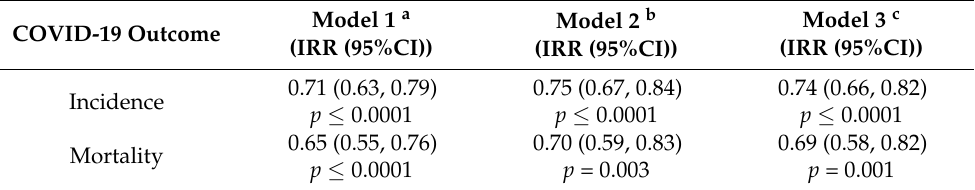
Table 1. Association of each one-unit increase in county-level objective social distancing with the risk of county-level COVID-19 incidence or mortality in the United States through 29 April 2020.